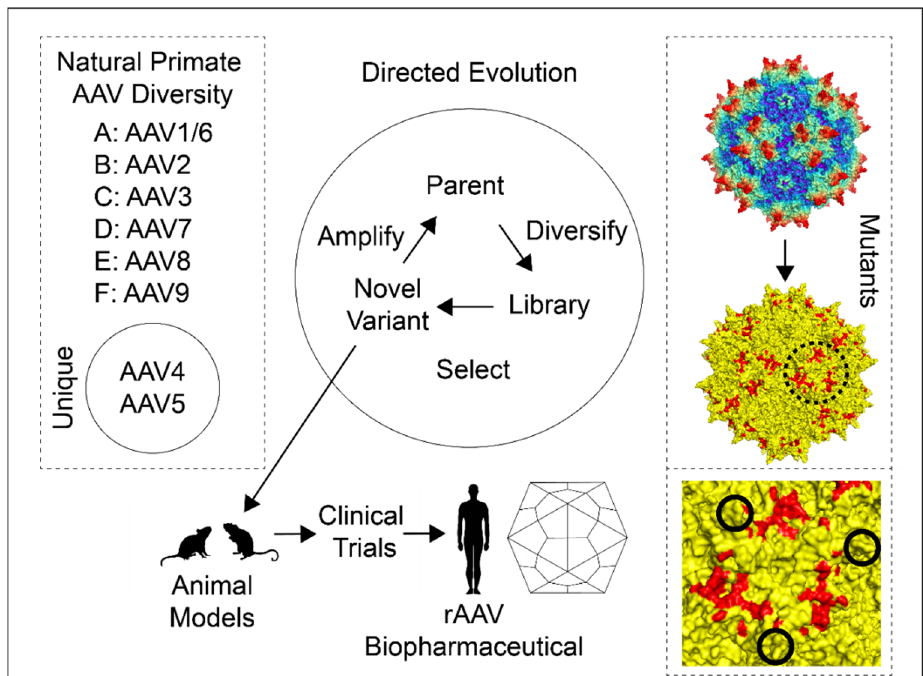
Figure 3. Capsid modification strategies. The three major approaches to capsid modifications are, from left to right: natural diversity (left dashed line box), directed evolution (middle), and mutants (right dashed line box). Natural primate AAV diversity includes the major and unique AAV clades. Directed evolution begins with parental serotypes, and these are diversified via recombination-based techniques (see text for details). This creates an AAV library that can be screened with selection of novel variants. Novel variants can then be amplified for additional rounds of selection or tested in animal models as a candidate rAAV biopharmaceutical. The mutants box consists of an AAV2 60-mer corresponding to Figure 2a at the top and a mutated yellow AAV2 60-mer at the bottom with mutations highlighted in red. The dashed-line circle surrounds the 3-fold axis, and a close-up view of this region is shown in the bottom right dashed box. Solid line circles show the peaks of each axis and the 3-fold depression is in the center. The three ~3.5 nm diameter red patches are “dead zones” first identified in Lochrie et al., 2006 [118] . Comparison of the top and middle models shows that the dead zone is mostly on a plateau between spikes where the PKD2 domain is bound in the AAV2-AAVR complex [119,120] . A summary of these mutations and others is provided in Supplementary Table S1. Structures were prepared using PyMOL [66] .